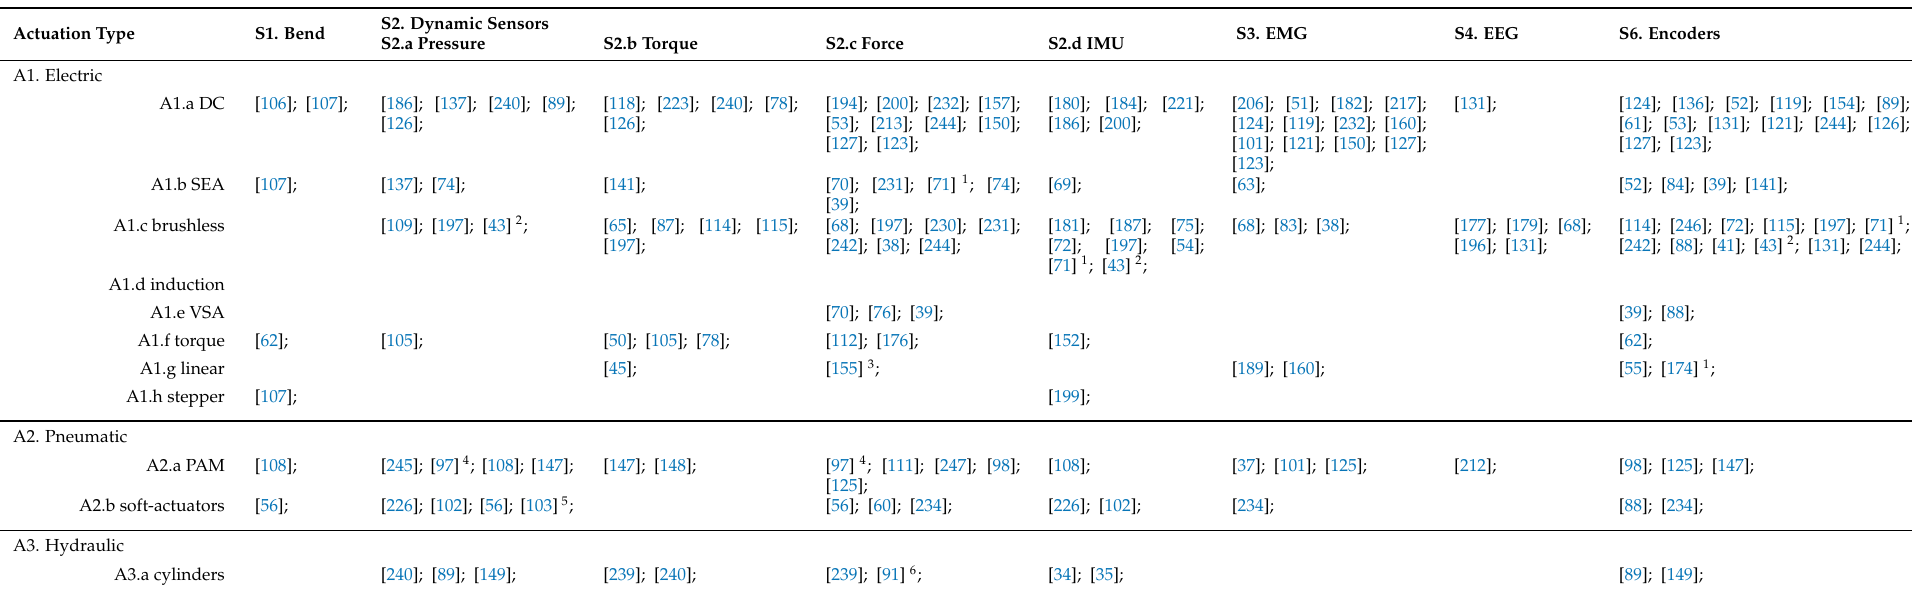
Table A5. Cross analysis of the paper distribution of sensors vs. actuator